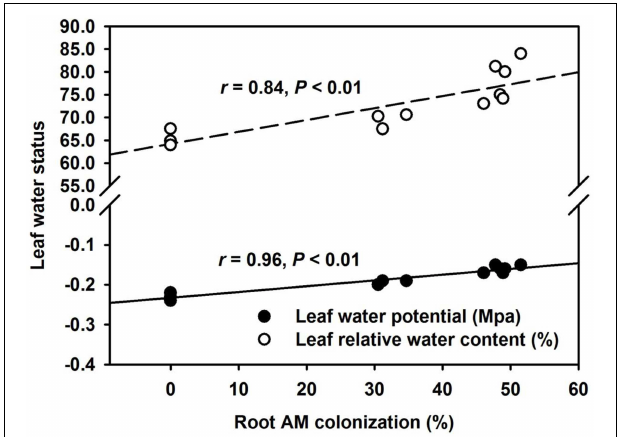
FIGURE 4 | Linear regression between root AM colonization and leaf water potential or leaf relative water content in trifoliate orange ( Poncirus trifoliata ) seedlings inoculated with or without Funneliformis mosseae and grown in 37 µ m nylon-mesh separated root/hyphae compartments ( n = 12 ).